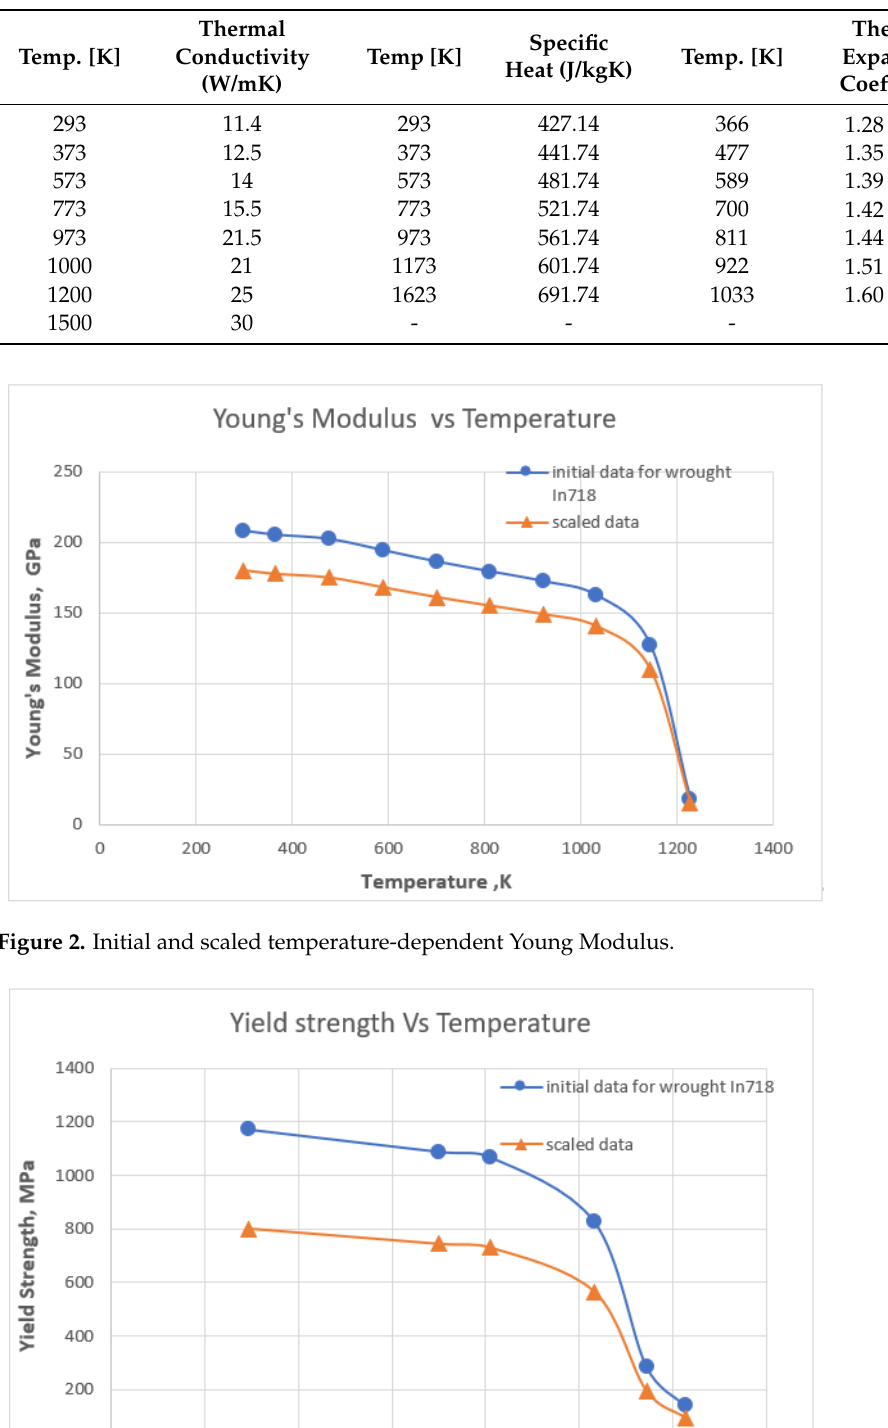
Table 1. Properties of Inconel718, adapted with permission from ref. [25] 2021 Elsevier.